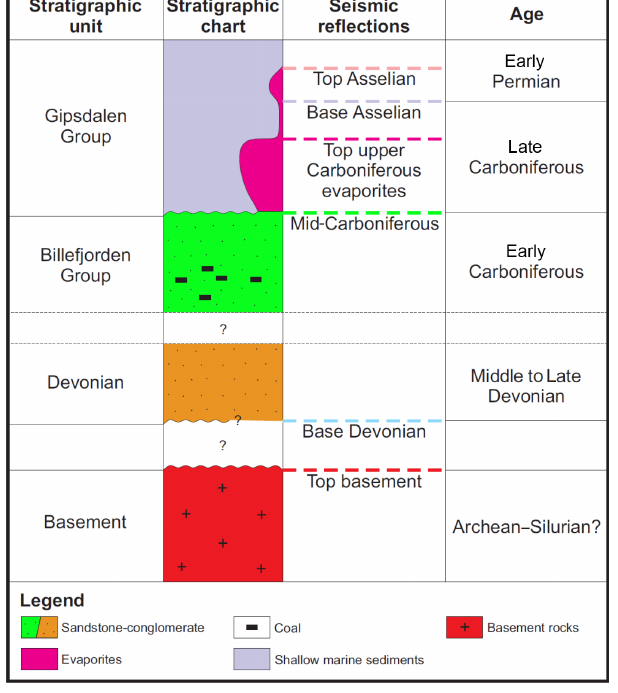
Figure 3. Simplified stratigraphic chart of late Paleozoic sedimen- tary successions on the Finnmark Platform and in the southwestern- most Nordkapp basin. From left to right, columns indicate the unit name, the successions’ dominant lithologies and types of succession boundaries (undulating lines: erosional unconformity; straight line: conformity; dashed lines: uncertain), interpreted seismic reflections (see Figs. 4 and 5), and the units age. Lithological legend at the bottom.